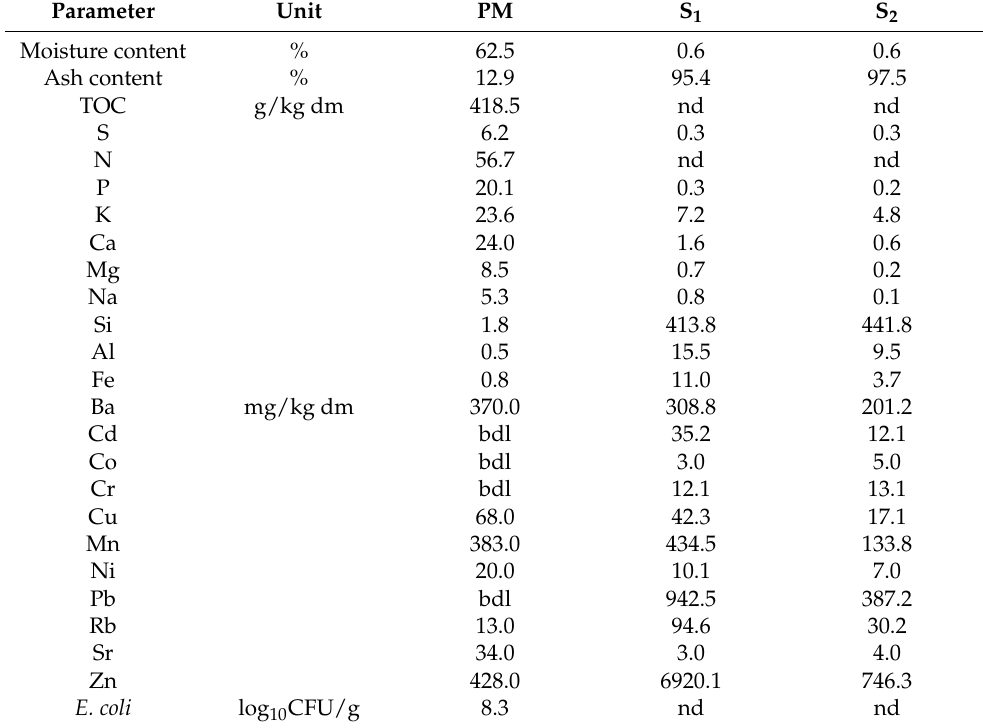
Table 1. Chemical characterization of soils and poultry manure used in this